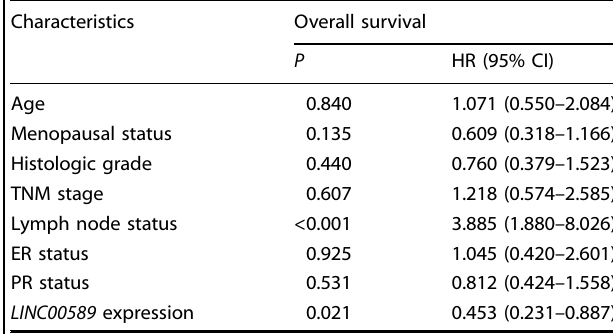
Table 1. Association of LINC00589 expression with clinicopathological features in trastuzumab-treated HER2-positive breast cancer patients.